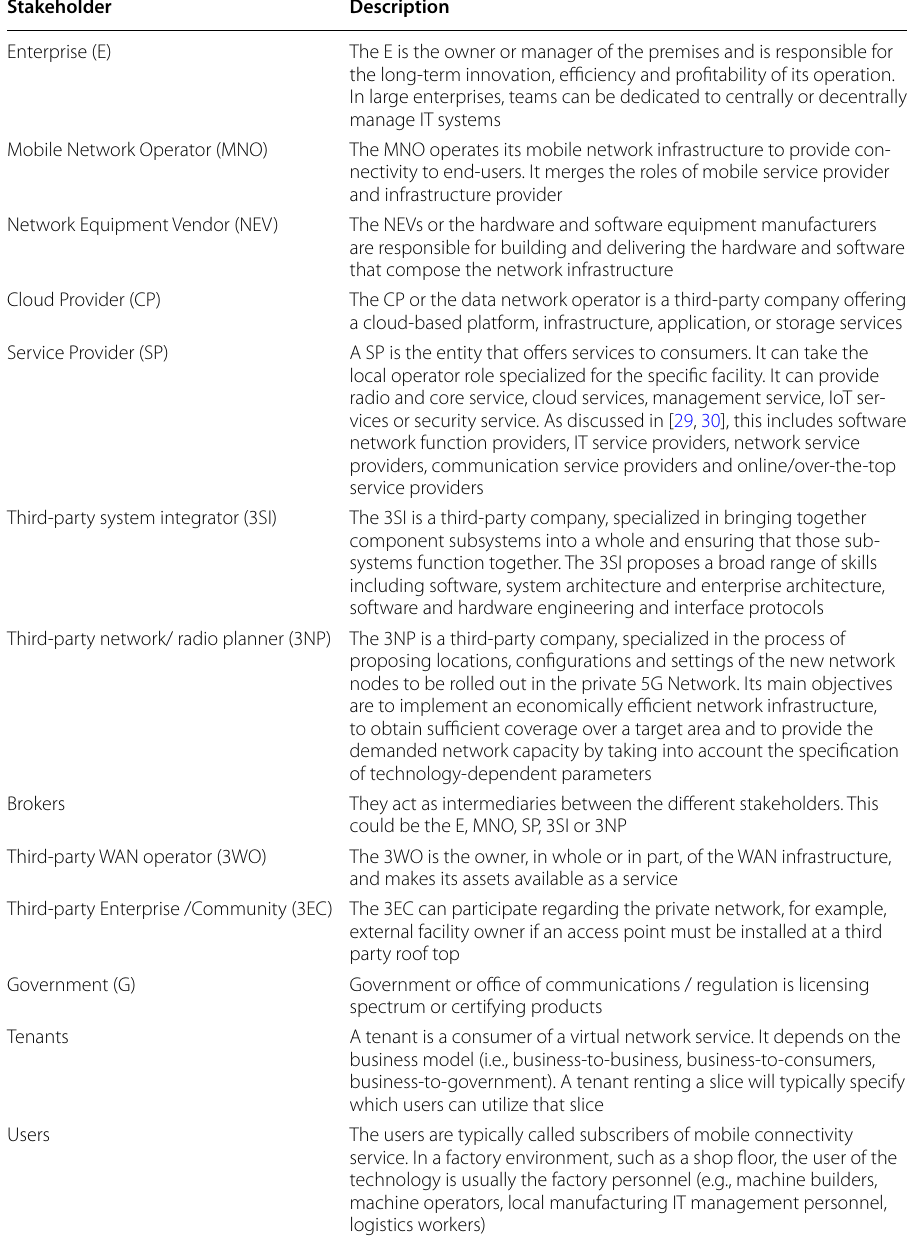
Table 3 Description of stakeholders Stakeholder Description Enterprise